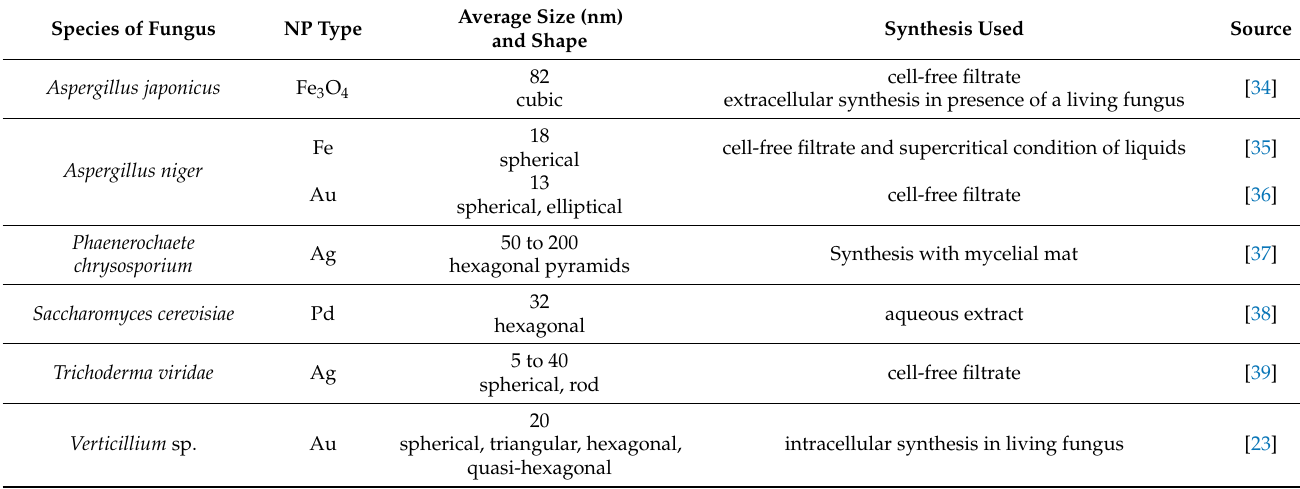
Table 1. Selected examples of fungi producing NPs of different